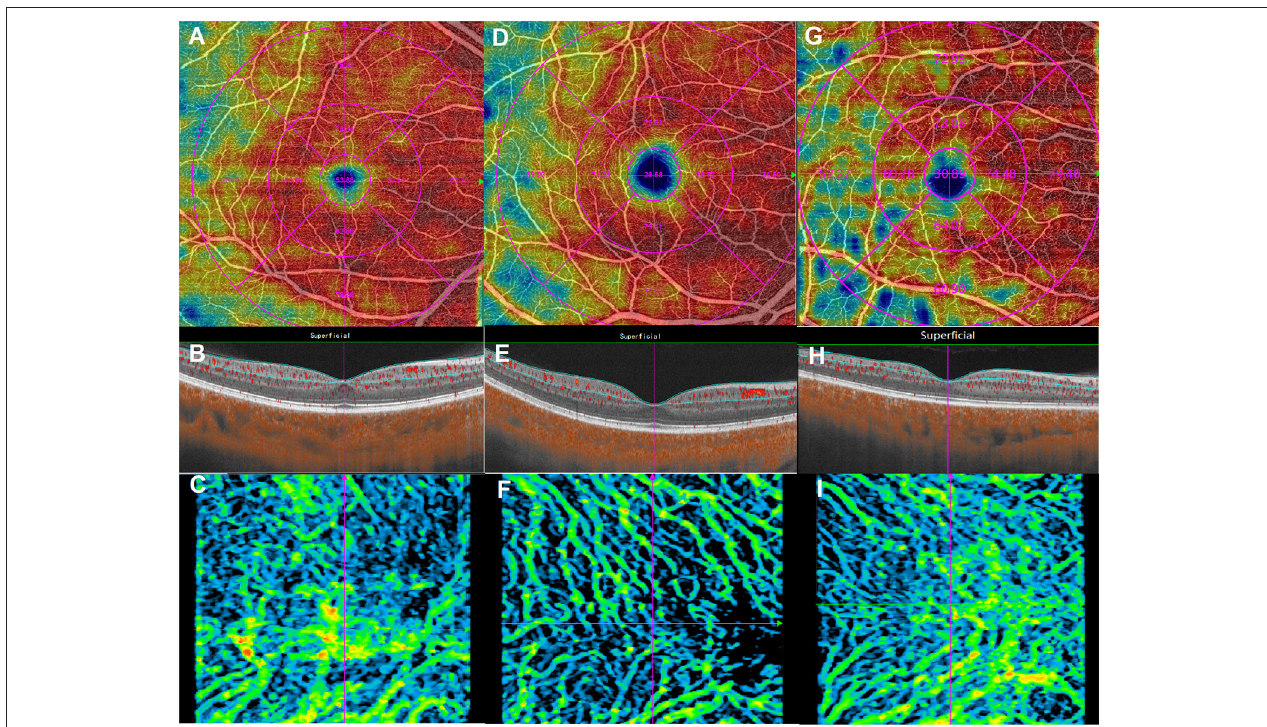
FIGURE 1 | Macular microvasculature images from the 6 × 6mm scan model: en face optical coherence tomography angiography images of the superficial retinal vessel density (upper), B-scans (middle), and choroidal vascularity index (lower). (A–C) are from the same eye in the human immunodeficiency virus (HIV)-negative group; (D–F) are from the same eye in the HIV-positive group; (G–I) are from the same eye in the HIV-positive with microvasculopathy group. 3-mm diameter inner circle of the ETDRS chart. All